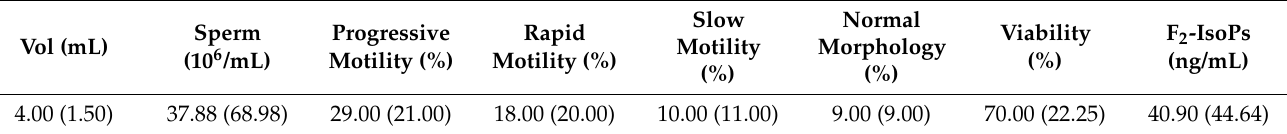
Table 1. Median and IQR of semen variables in 192 individuals.